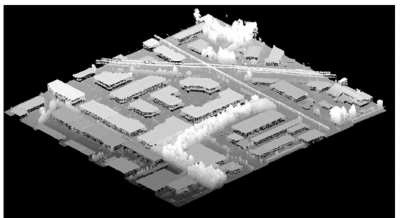
Figure 5. 3D perspective view of the LiDAR data shown in Figure 4a.